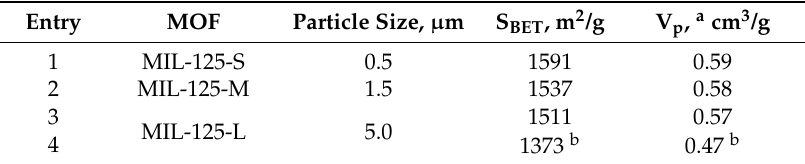
Table 1. The physicochemical properties of